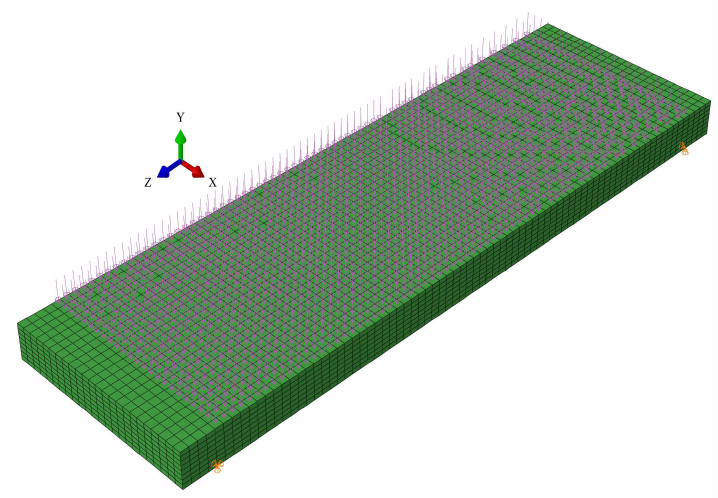
Figure 5. The details of the created 3D FE model of the slab